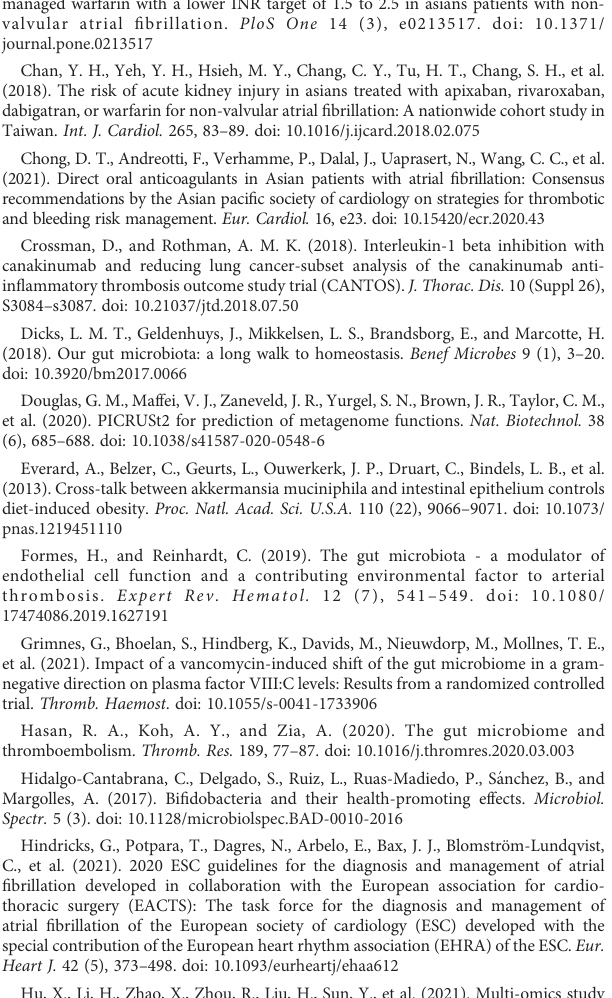
Shannon index. (C) Beta diversity was demonstrated by PCoA based on weighted UniFrac distances. SUPPLEMENTARY FIGURE 2 (A – C) Alpha diversity among the three anticoagulated subgroups. (D) Beta diversity was demonstrated by PCoA based on weighted UniFrac distances in the three anticoagulated subgroups. SUPPLEMENTARY FIGURE 3 Proportion of top 30 dominant phyla in the three anticoagulated